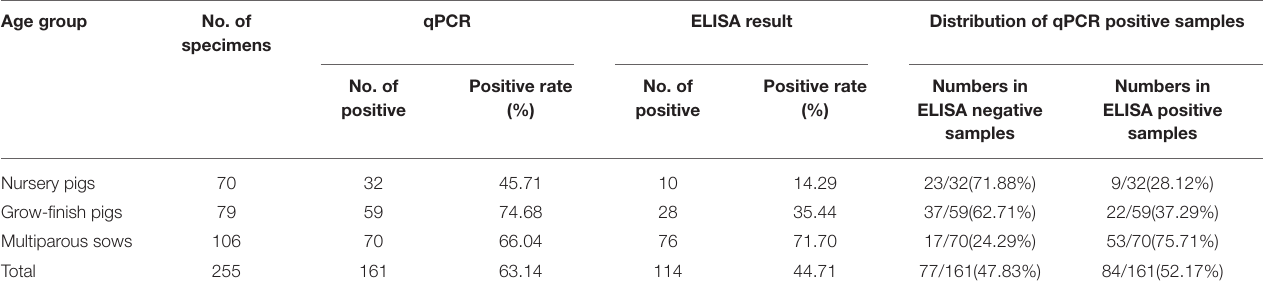
TABLE 5 | The PCV3 DNA positive rates in serum samples of different age groups investigated by real-time PCR (qPCR) and the distribution of qPCR positive samples. Age group No. of specimens